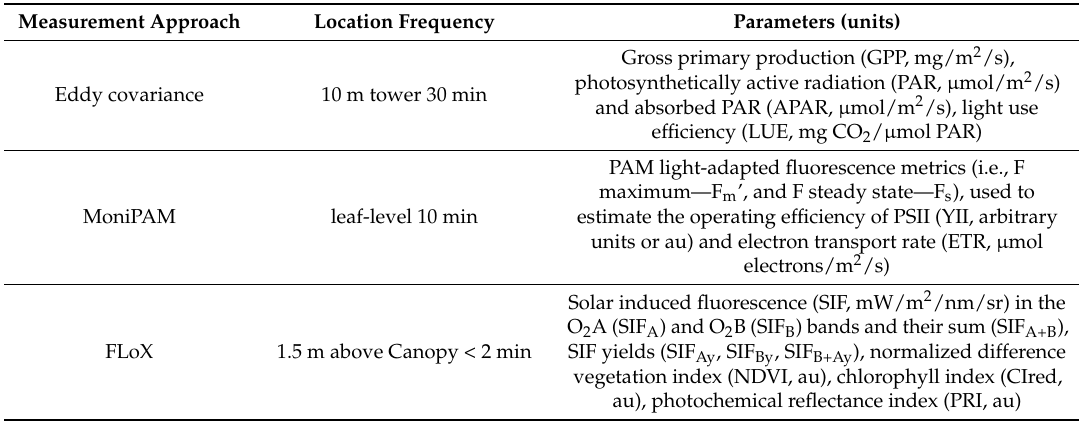
Table 1. Complementary measurements of corn ( Zea mays L.), collected across the 2017 growing season at OPE3, Greenbelt,